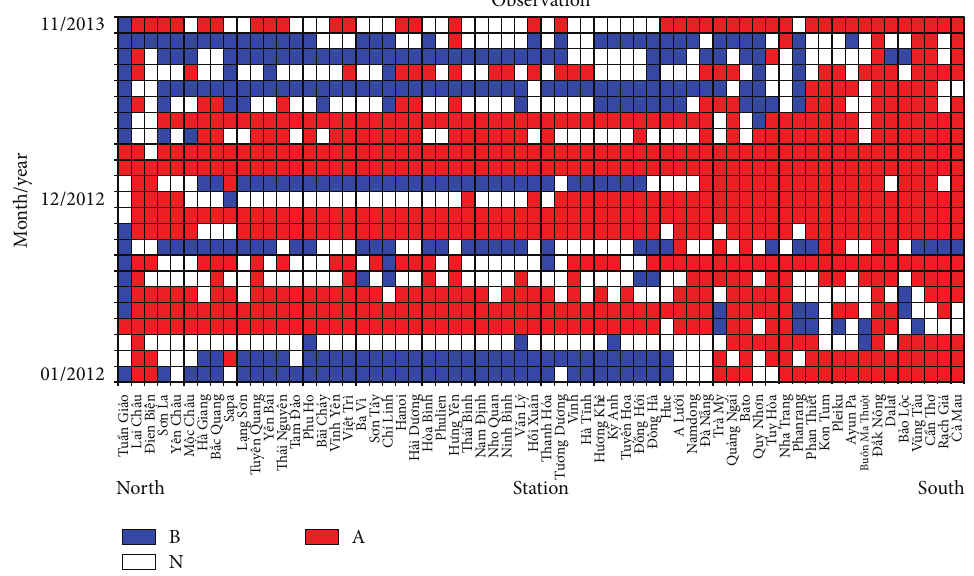
Figure 6: Observed tercile probability at 64 stations from January 2012 to November 2013. B (blue color), N (white color), and A (red color) indicate below-normal , normal , and above-normal probabilities,